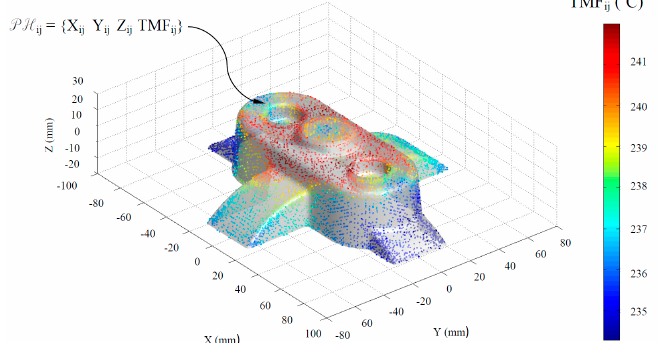
Figure 6. Definition of the hybrid matrix PH ij from the discrete geometry P’ n ∈ ℝ 3 and from the temperature of the melt plastic front TMF ij in each node.